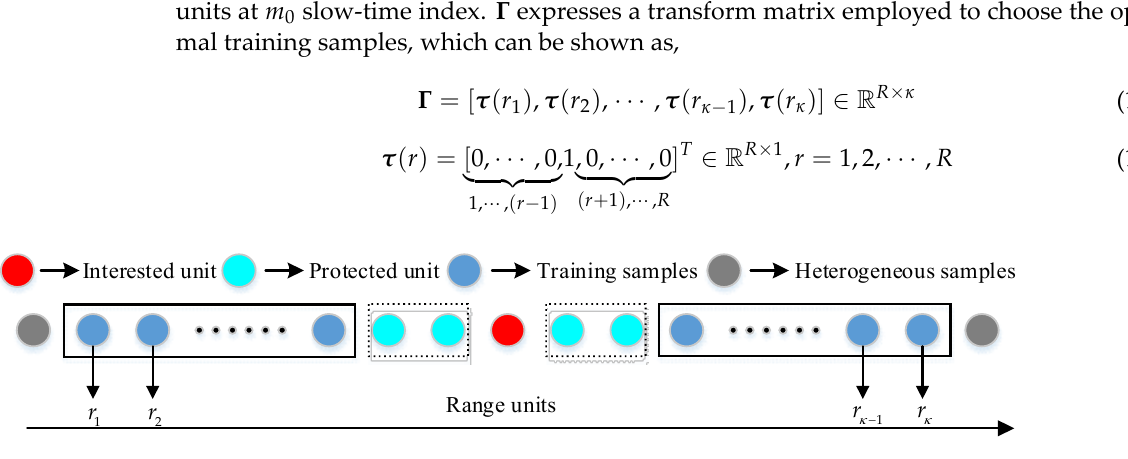
Figure 3. The optimal training samples structure.